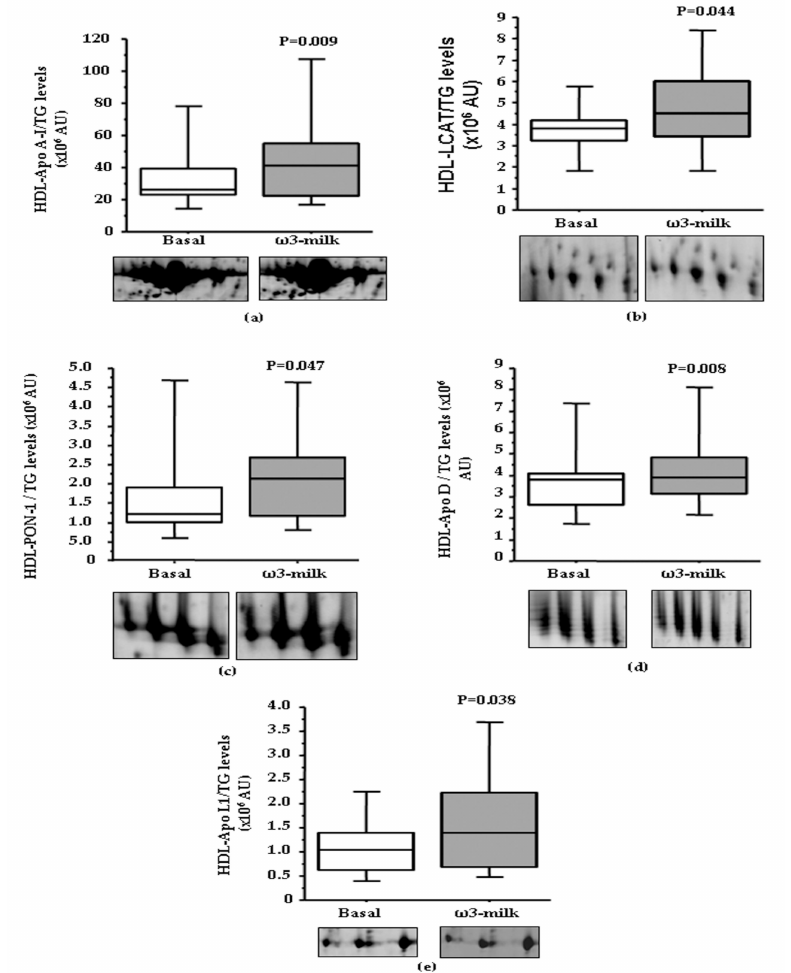
Figure 3. Impact of the intake of ω 3-milk on the high density lipoprotein (HDL) profile. Box-Plots and 2-DE representative images showing the significant changes induced in HDL proteins by ω 3-milk: ( a ) Apo A–I ( p = 0.009); ( b ) lecitin cholesterol acyltransferase (LCAT) ( p = 0.044); ( c ) paraoxonase-1 (PON-1) ( p = 0.047); ( d ) Apo D ( p = 0.008); and ( e ) Apo L1 ( p =